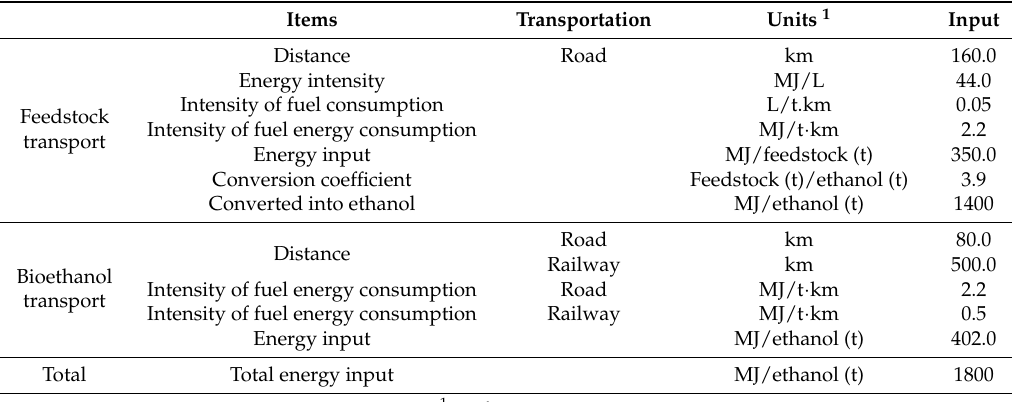
Table 4. Energy consumption in the transport